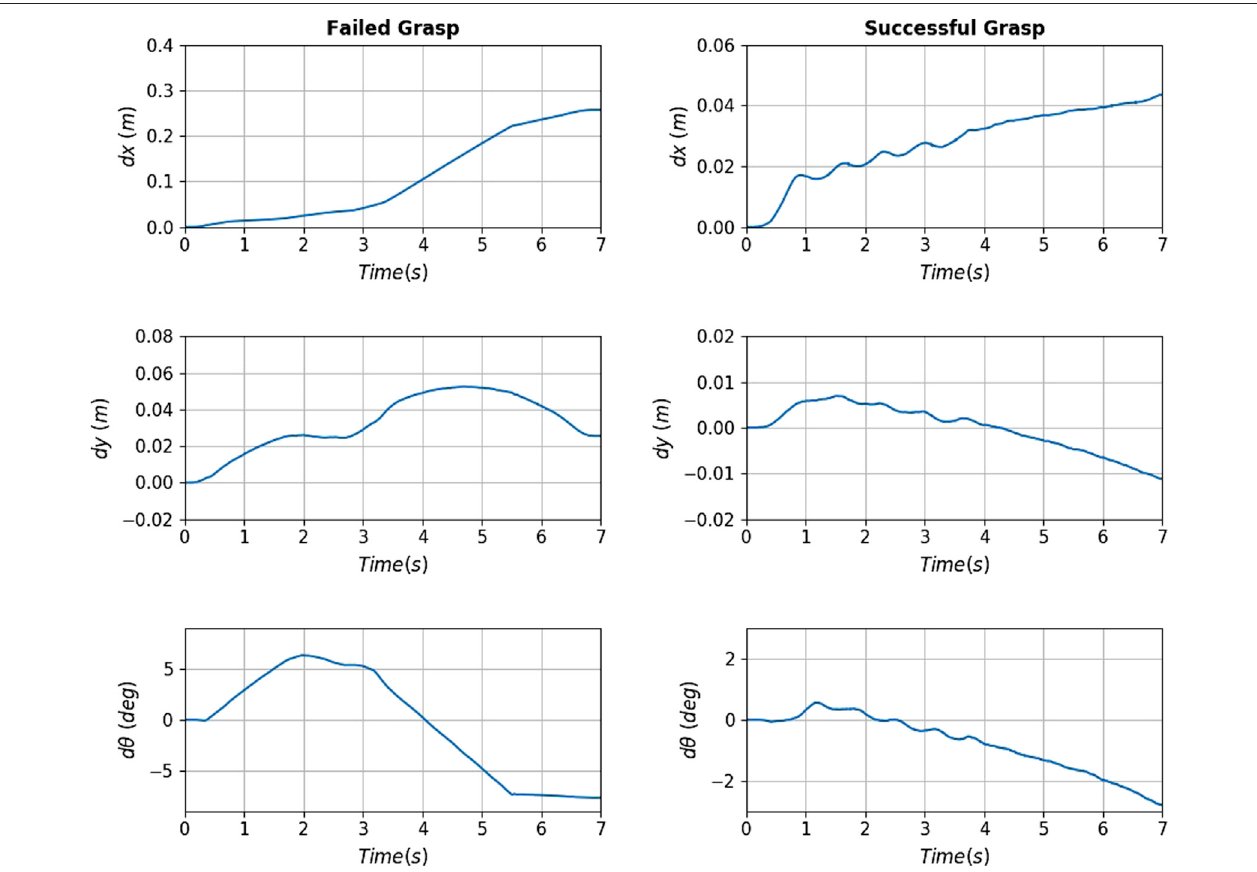
FIGURE 16 | Slippage signals for the failed ( left column) and successful ( right column) of Figure 15 . The translational slippage ( top and middle graphs) and rotational slippage ( bottom graphs) over the whole pull duration are shown. For the failed grasp, at about 3.3 s the robot loses contact with the target. The successful grasp manages to yield relatively low slippages, securing the capturing of the